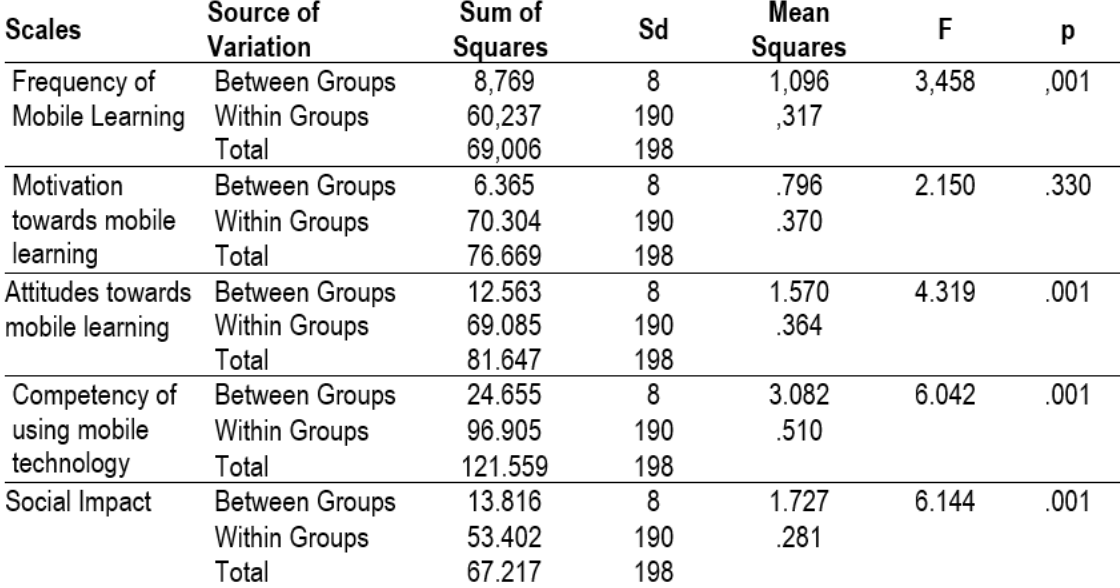
Findings of one-way ANOVA analysis according to